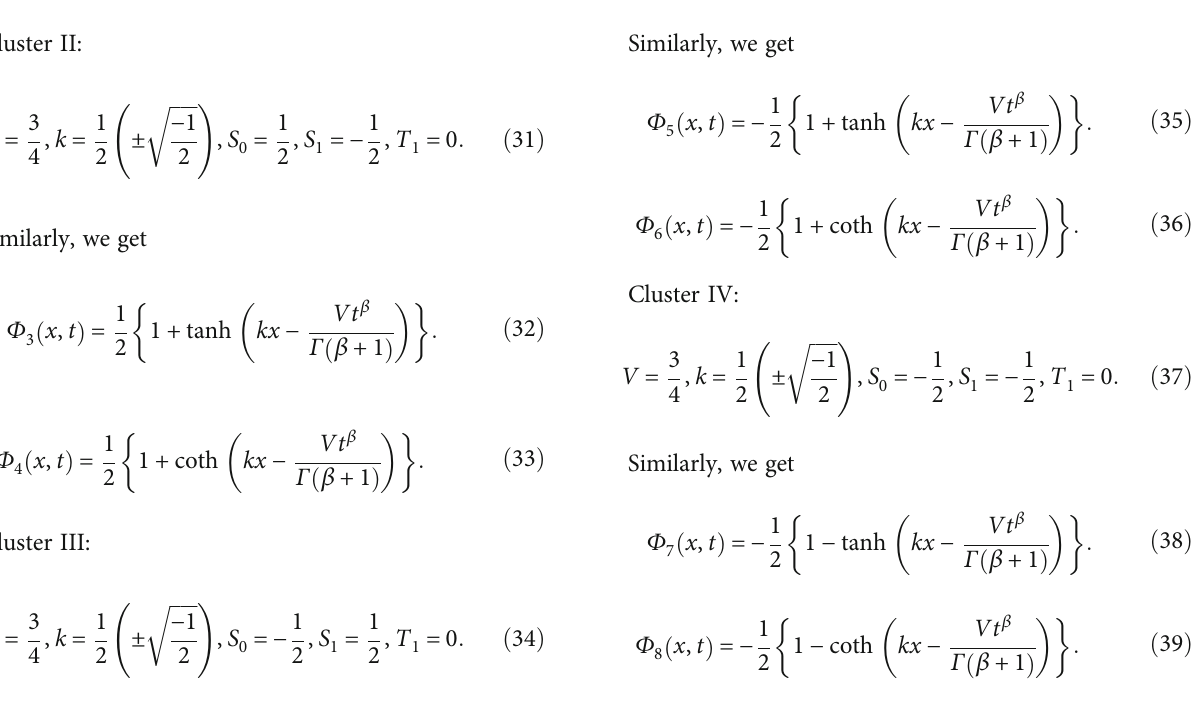
Figure 6: The graphical representation of the solution Φ real contour plot, and (d) imaginary contour